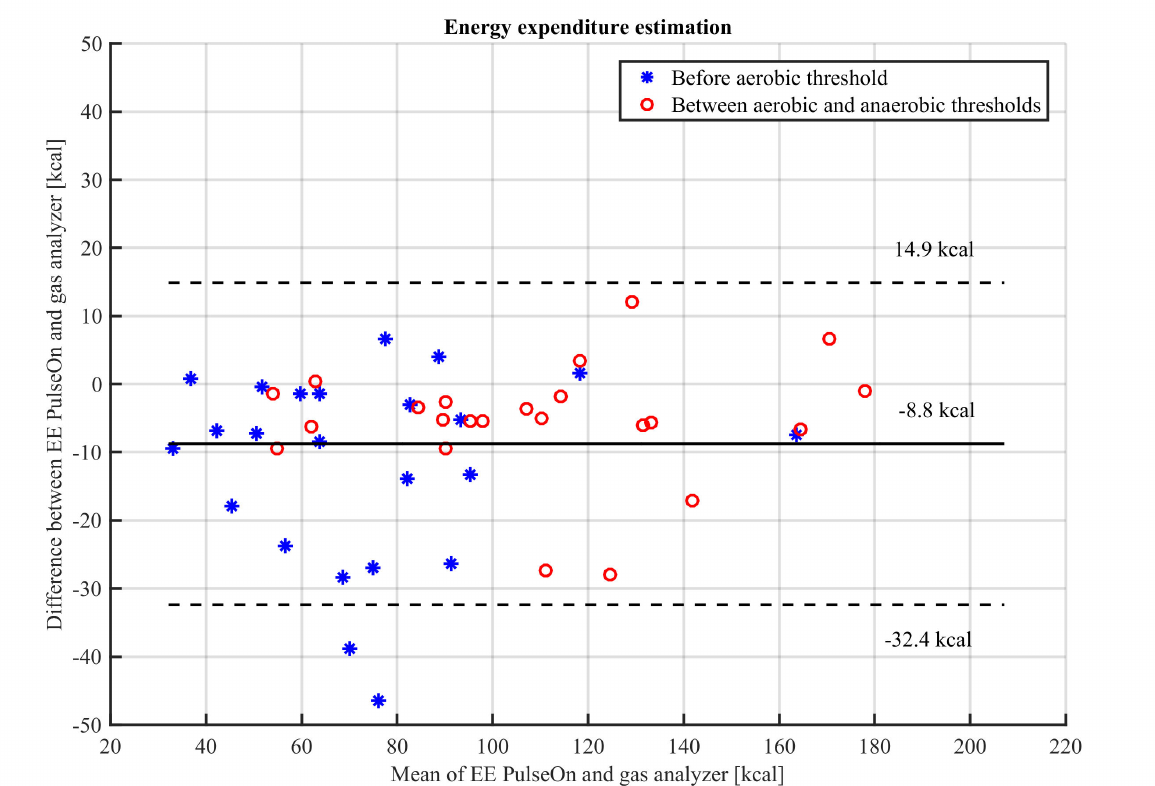
Figure 5. Bland−Altman plot comparing an energy expenditure estimation with a wrist PPG device and gas analyzer during a maximum exercise test−the asterisk denotes data before the aerobic threshold, while dots represent data between aerobic and anaerobic thresholds (solid horizontal line: bias, dashed lines: 95% confidence limits of